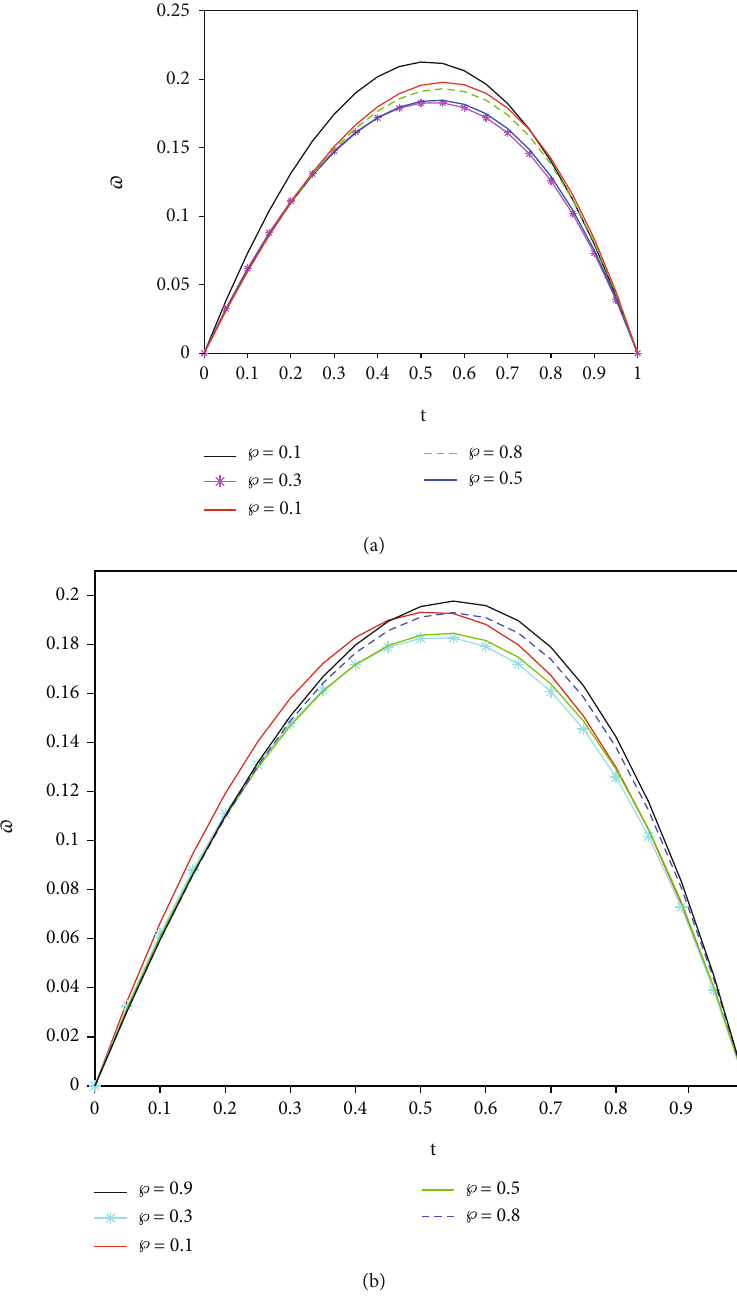
Figure 8: Approximate solution for Example 10 when (a) θ = − 0 : 5 and (b) θ = 0 : 5